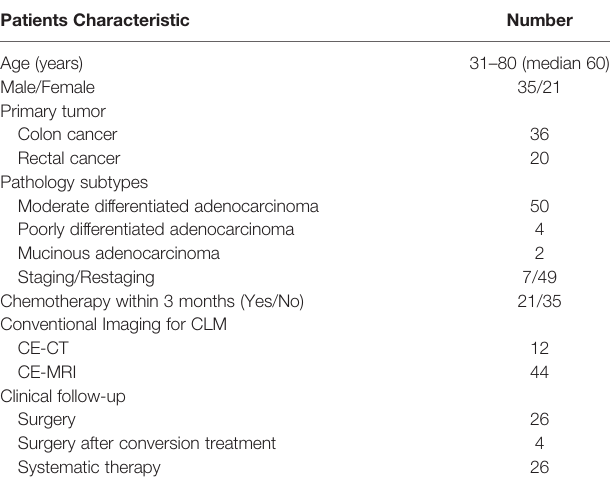
TABLE 1 | Patient characteristics of this